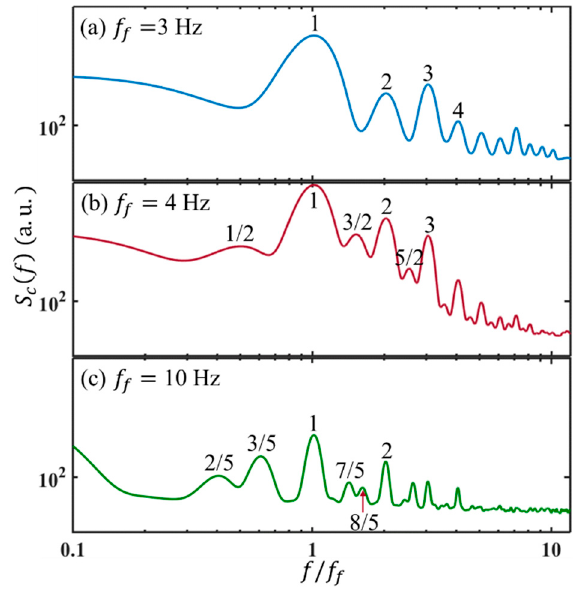
Figure 12. Peaks of temporal power spectra of concentration under 𝑉 (cid:3006) = 35.6 V (cid:2926)(cid:2879)(cid:2926) . at 3 µL/min and different forcing frequencies. ( a ) 𝑓 (cid:3033) = 3 Hz. ( b ) 𝑓 (cid:3033) = 4 Hz. ( c ) 𝑓 (cid:3033) = 10 Hz.